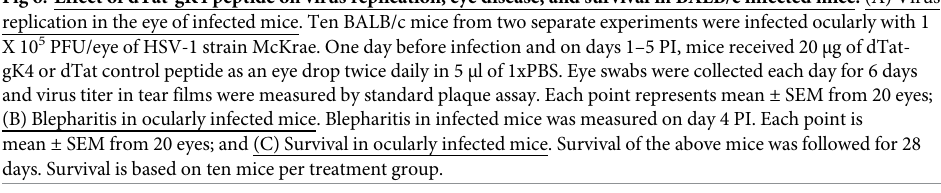
Fig 6. Effect of dTat-gK4 peptide on virus replication, eye disease, and survival in BALB/c infected mice. (A) Virus replication in the eye of infected mice. Ten BALB/c mice from two separate experiments were infected ocularly with 1 X 10 5 PFU/eye of HSV-1 strain McKrae. One day before infection and on days 1–5 PI, mice received 20 μ g of dTat- gK4 or dTat control peptide as an eye drop twice daily in 5 μ l of 1xPBS. Eye swabs were collected each day for 6 days and virus titer in tear films were measured by standard plaque assay. Each point represents mean ± SEM from 20 eyes; (B) Blepharitis in ocularly infected mice. Blepharitis in infected mice was measured on day 4 PI. Each point is mean ± SEM from 20 eyes; and (C) Survival in ocularly infected mice. Survival of the above mice was followed for 28 days. Survival is based on ten mice per treatment